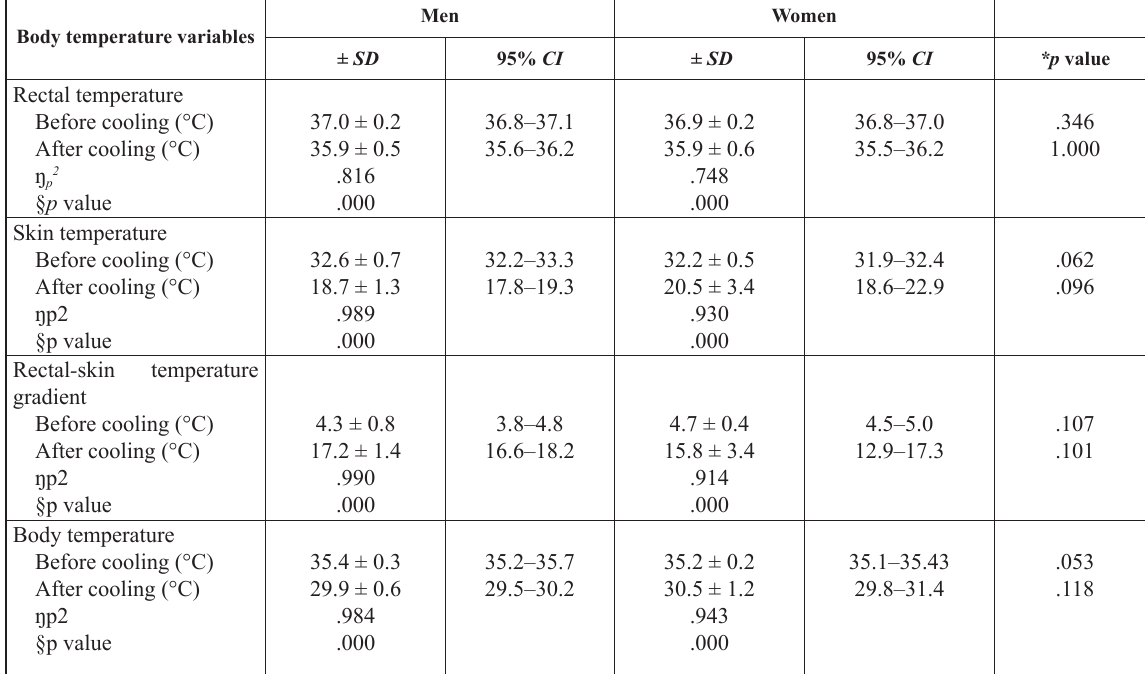
Table 2. Body temperature variables before and after body